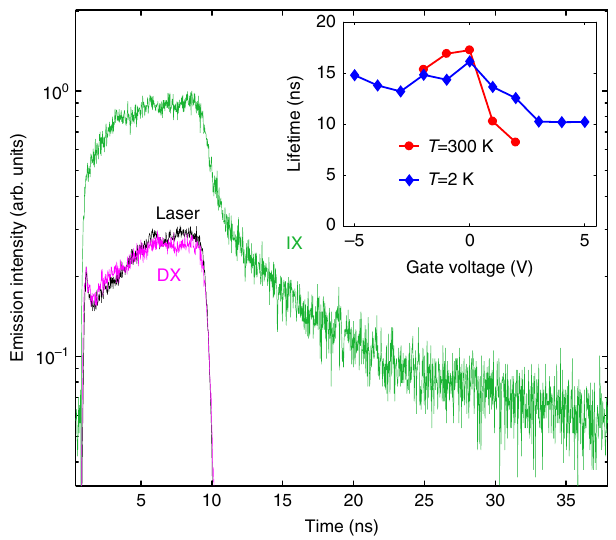
Fig. 3 Emission kinetics. Emission kinetics at energies of 1.46 – 1.65 eV corresponding to the IX spectral range (green), 1.89 eV corresponding to the DX spectral range (magenta), and 3.07 eV corresponding to the excitation laser (black) at T = 300 K and V g = 0. IX lifetimes are shown in the inset as a function of gate voltage V g for T = 2 and 300 K, see text. The laser excitation has a pulse duration of 10 ns and a period of 40